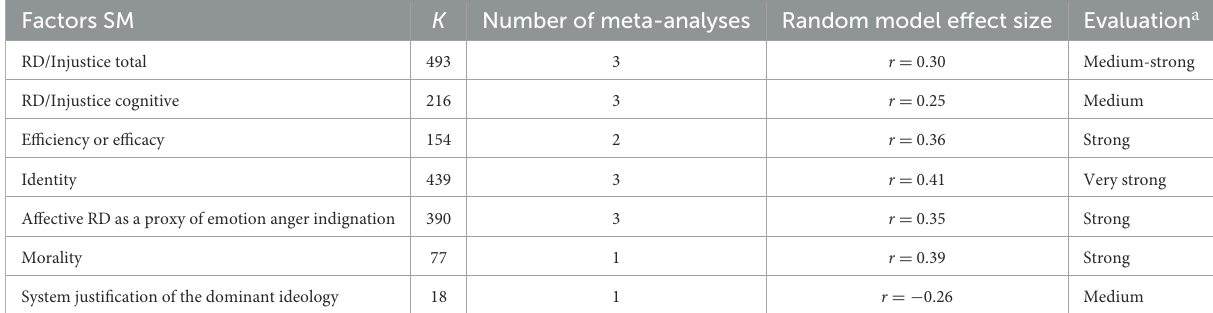
TABLE 7 Evidence-based explanatory factors for participation in CB and